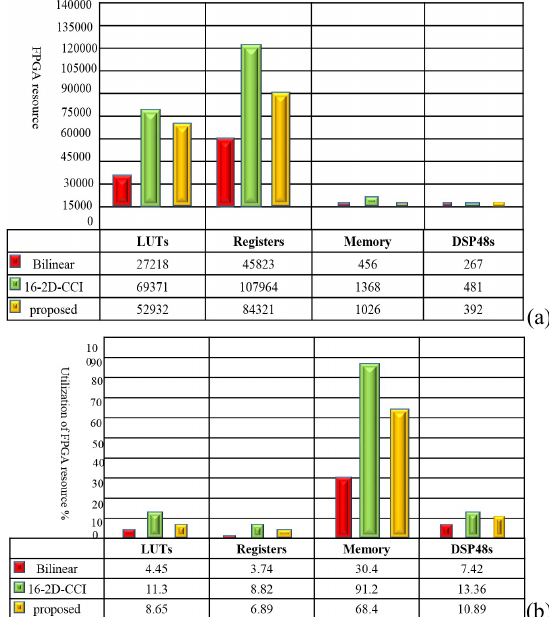
Figure 15. The utilization ratio of logic units for bilinear interpolation method, 16-2D-CCI algorithm, and PP-2D-CCI scheme. (a) The occupied FPGA resources. (b) The utilization ratio of logic